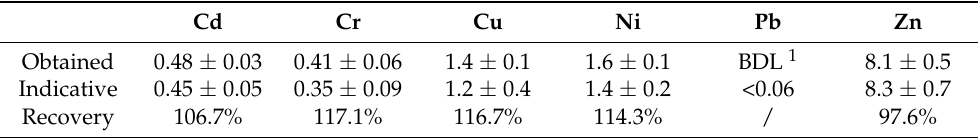
Table 2. Comparison of calcium chloride extractable element content-obtained and indicative values of BCR-483 certified reference